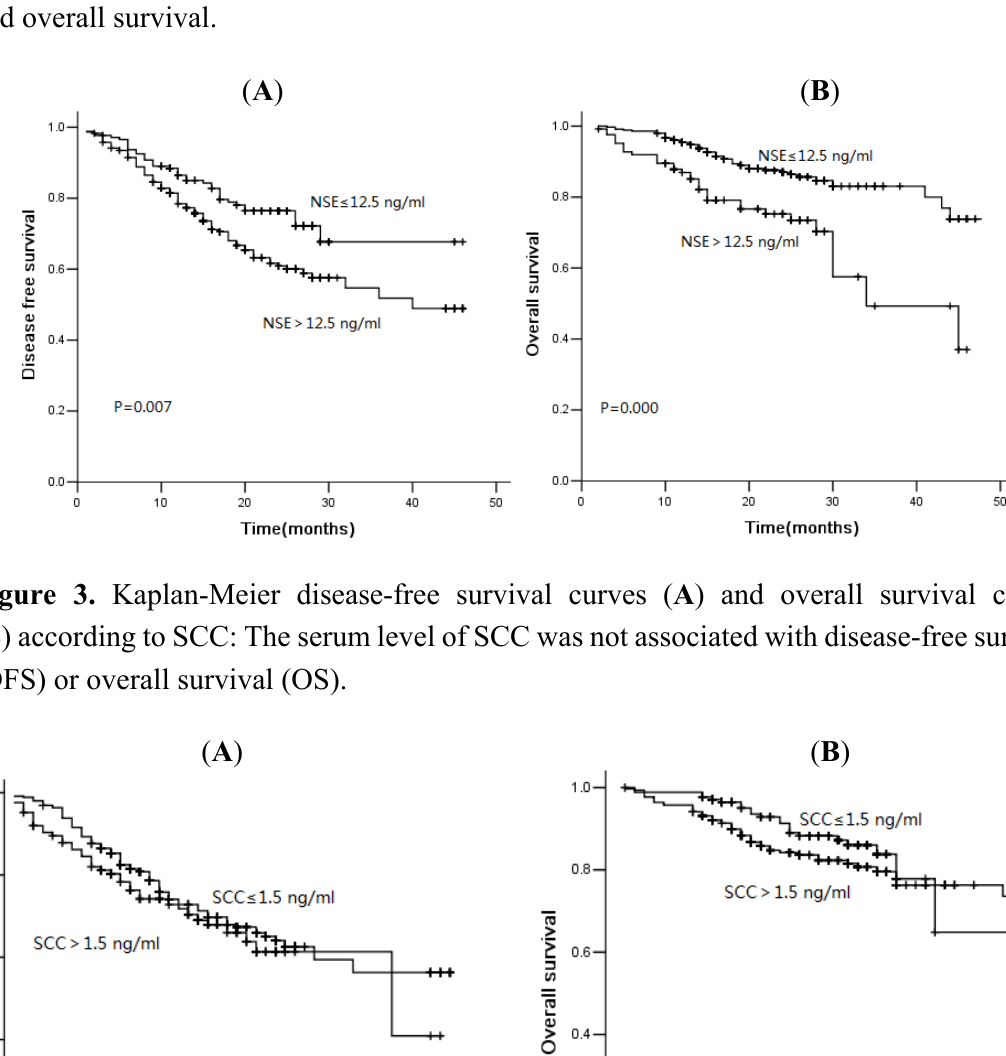
Figure 2. Kaplan-Meier disease-free survival curves ( A ) and overall survival curves ( B ) according to NSE: patients with high levels of NSE showed shorter disease-free survival and overall survival.